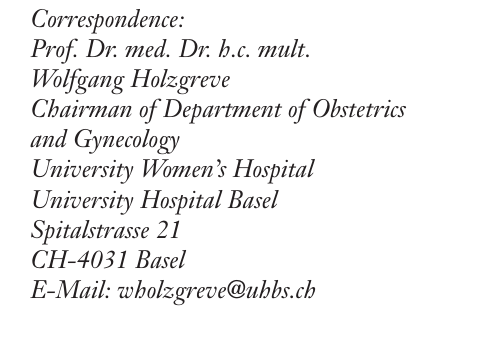
Table 3 Short-term engraft- ment (1–2 weeks post partum) of allogeneic versus autologous transplantation in White Alpine sheep by FACS analysis (PKH26-labelling). Mean % donor cells; t-test (mean, p) or Mann-Whitney Rank Sum test (median, p; if normality test failed,